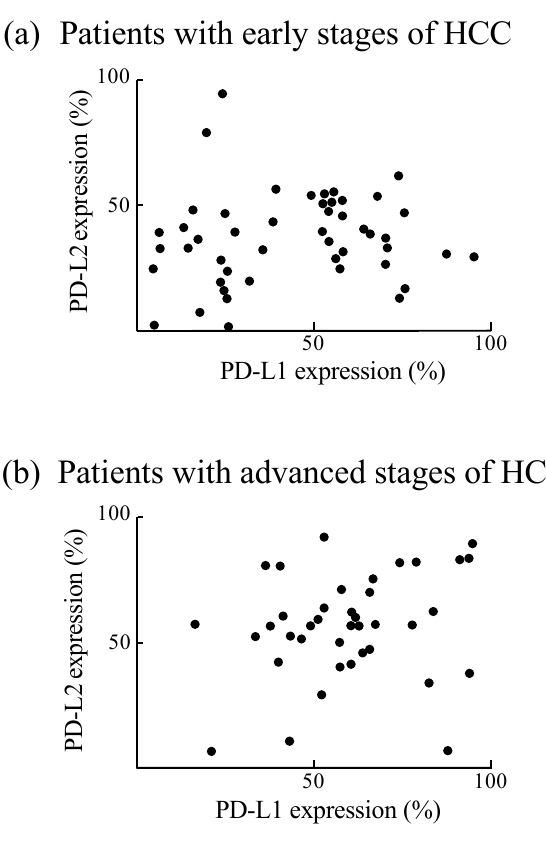
Figure 4. PD-L expressions in CD14 + cells from patients with several stages of HCC. CD14 + cells were isolated from peripheral blood of patients with early stages of HCC ( n = 48) ( a ) and advanced stages ( n = 41) ( b ). These cells were stained for PD-L1 and PD-L2 and assayed for flow cytometry.